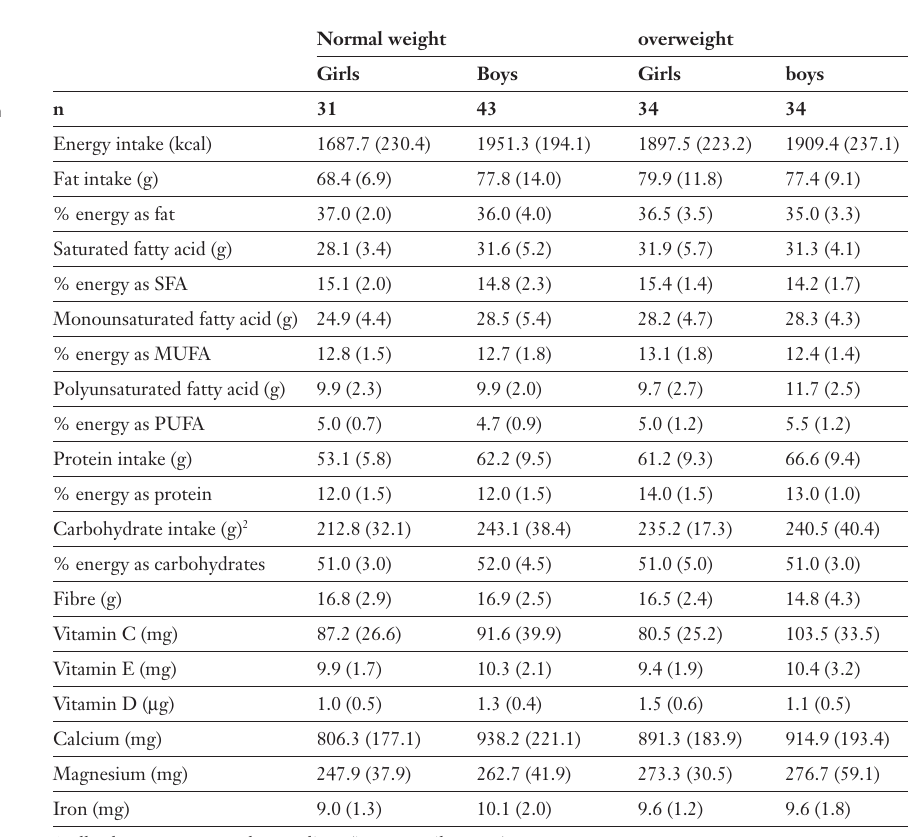
Table 2 Dietary intakes of normal weight and overweight children grouped by gender.